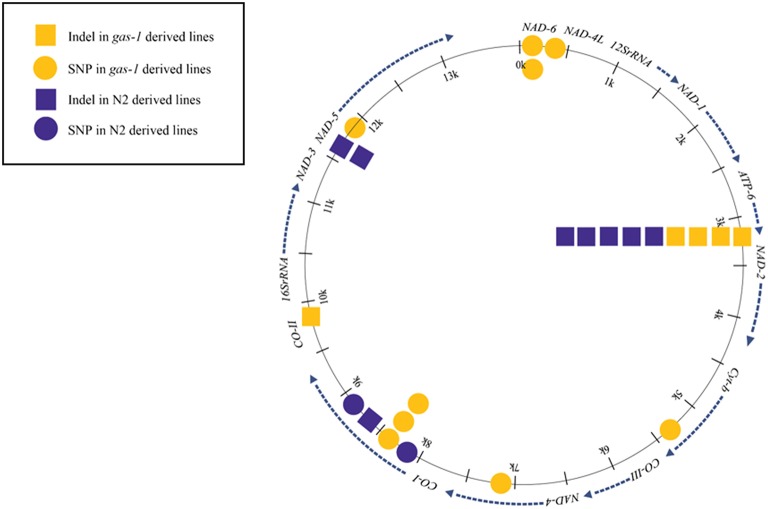
Schematic of Mitochondrial Indel and Single-Base Substitution Heteroplasmies. All indel and single-base substitution events for all wild-type N2 and gas-1 lines.